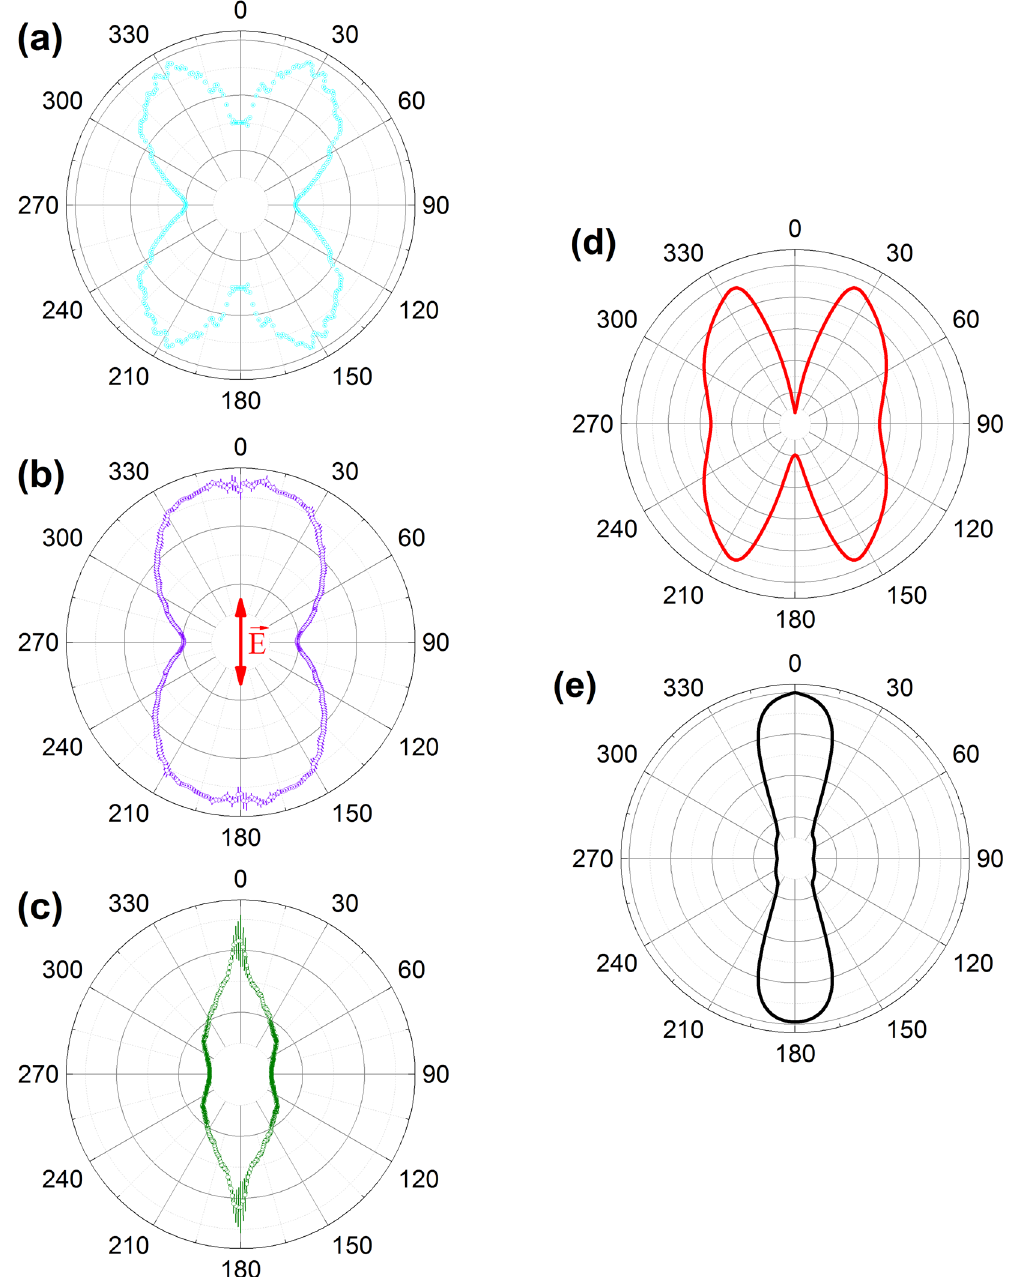
Figure 2. (Left) Experimental C 2 D + photofragment angular distributions arising from n ω + C 2 D 2 → C 2 D 2 + → C 2 D + + D. Experimental laser parameters are about 5 fs pulse duration and a central wavelength of 740 nm. The laser polarization is vertical (along the 0–180° direction) in all panels, as indicated by the arrow. ( a ) Experimental results with I peak = 4 × 10 15 W cm − 2 and I avg = 4 × 10 13 W cm − 2. ( b ) I peak = 8 × 10 15 W cm − 2 and I avg = 7 × 10 13 W cm − 2 . ( c ) I peak = 1 × 10 16 W cm − 2 and I avg = 1 × 10 14 W cm − 2 . (Right) Calculated angular distribution for the C 2 D + photofragments (see Methods for details). In panel (d) the calculations are done without including FDRC orbitals, at a uniform intensity of 9 × 10 13 W cm − 2 . ( e ) Similar calculations but with the ionization from FDRC orbitals included, at the same intensity of 9 × 10 13 W cm − 2 . The symmetry of the acetylene HOMO and LUMO are π u and π g ,